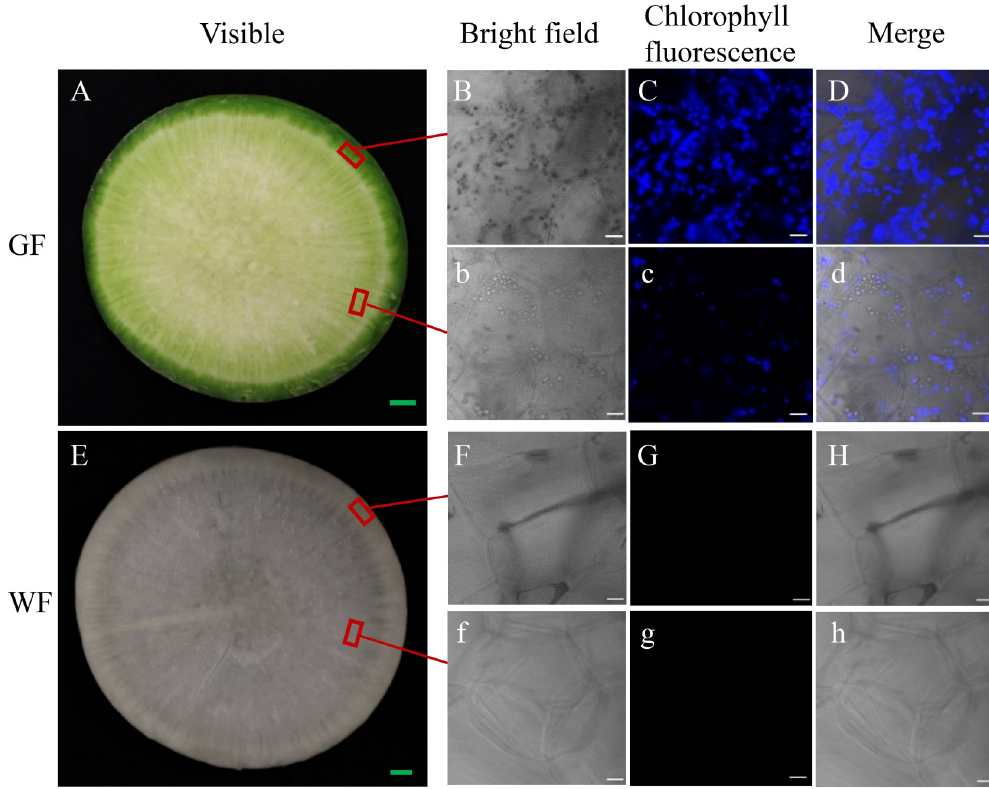
Fig 1. The skin and flesh phenotype of radish green flesh (GF) (A–D, b–d) and white flesh (WF) (E–H, f–h) at S5. A, E, cross section of GF (A) and WF (E) at visible light; B, b, F, f, micrograph at bright field; C, c, G, g, Chl auto-fluorescence image; D, d, H, h , the merged micrograph of bright field and Chl auto-fluorescence images. Green scale bars = 0.5cm, white scale bars = 20 μ m.